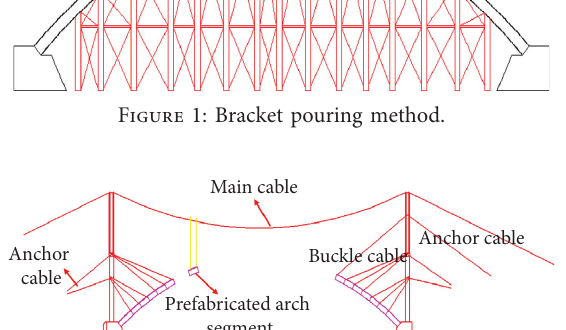
Figure 2: Arch rib prefabricated hoisting method.